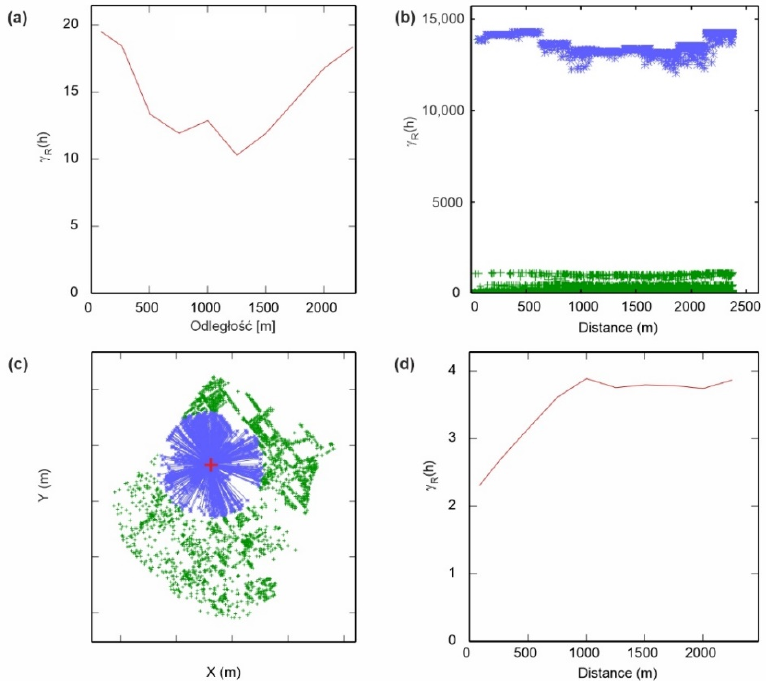
12 of 26 Figure 6. Pearson correlations and Spearman rank correlations between Cu abundance (aCu) and abundance of accompanying elements (aCo, aNi, aPb, and aV) in the Cu-Ag Rudna deposit. 4.2. Variography Calculations of relative variograms were preceded by the elimination of outliers from data sets, strongly distorting the form of empirical variograms and masking the non-ran- dom component of variability. Elimination of outliers was performed on the basis of the variogram cloud in ISATIS software [31]. The significance and purposefulness of using